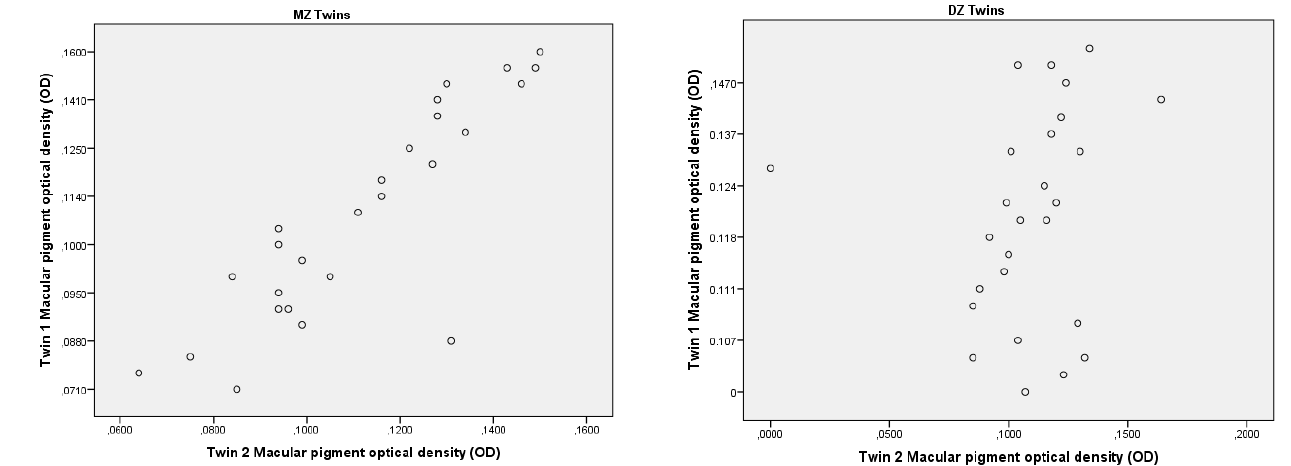
Figure 1. Scatter plots of MPOD in each twin’s right eye, twin 1 versus twin 2, in 56 MZ and 52 DZ twin pairs. MZ—monozygotic twins; DZ -dizygotic twins; OD—right eye.